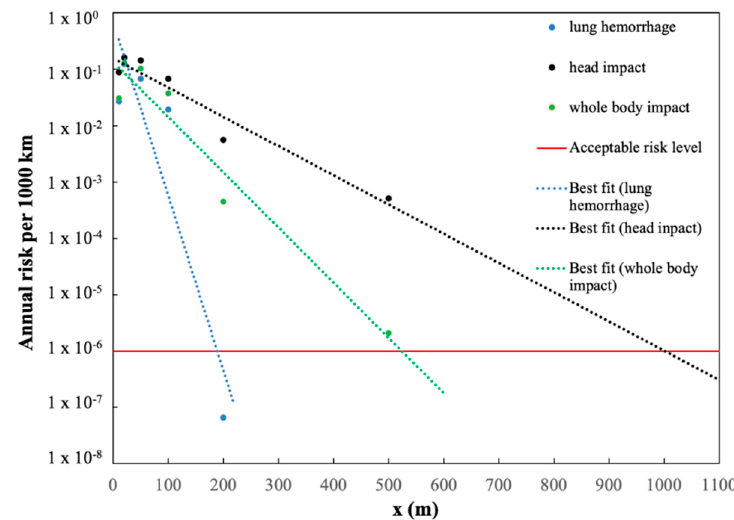
Figure 6. Annual risk per 1000 km of damage to people vs. safety distance (x (m)), in the case of blast strength 9 and atmospheric stability class F2.